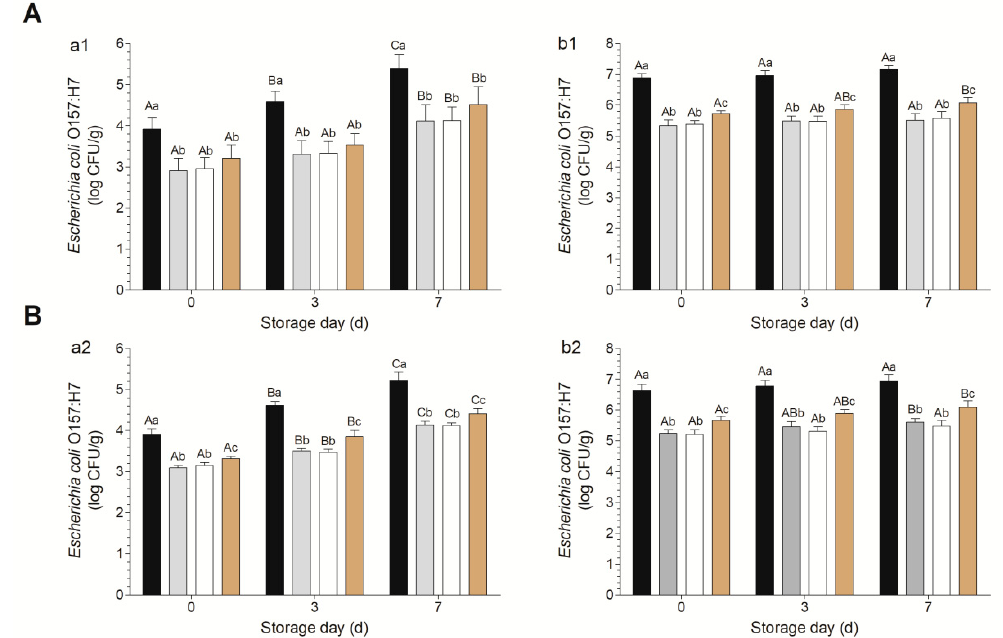
Figure 2. Decontamination effects of different combinations against Escherichia coli O157:H7 on fresh-cut spinach ( A ) and arugula ( B ). Panels a and b show results for low and high inoculation levels, respectively. Black, gray, white, and brown bars indicate the results for the control, 1% LA, 0.8% LA plus 0.2% AA, and 0.6% LA plus 0.4% AA, respectively. Note: within the same day, mean values with different lowercase letters are significantly different from each other ( p < 0.05); within the same treatment, mean values with different capital letters are significantly different from each other ( p < 0.05).